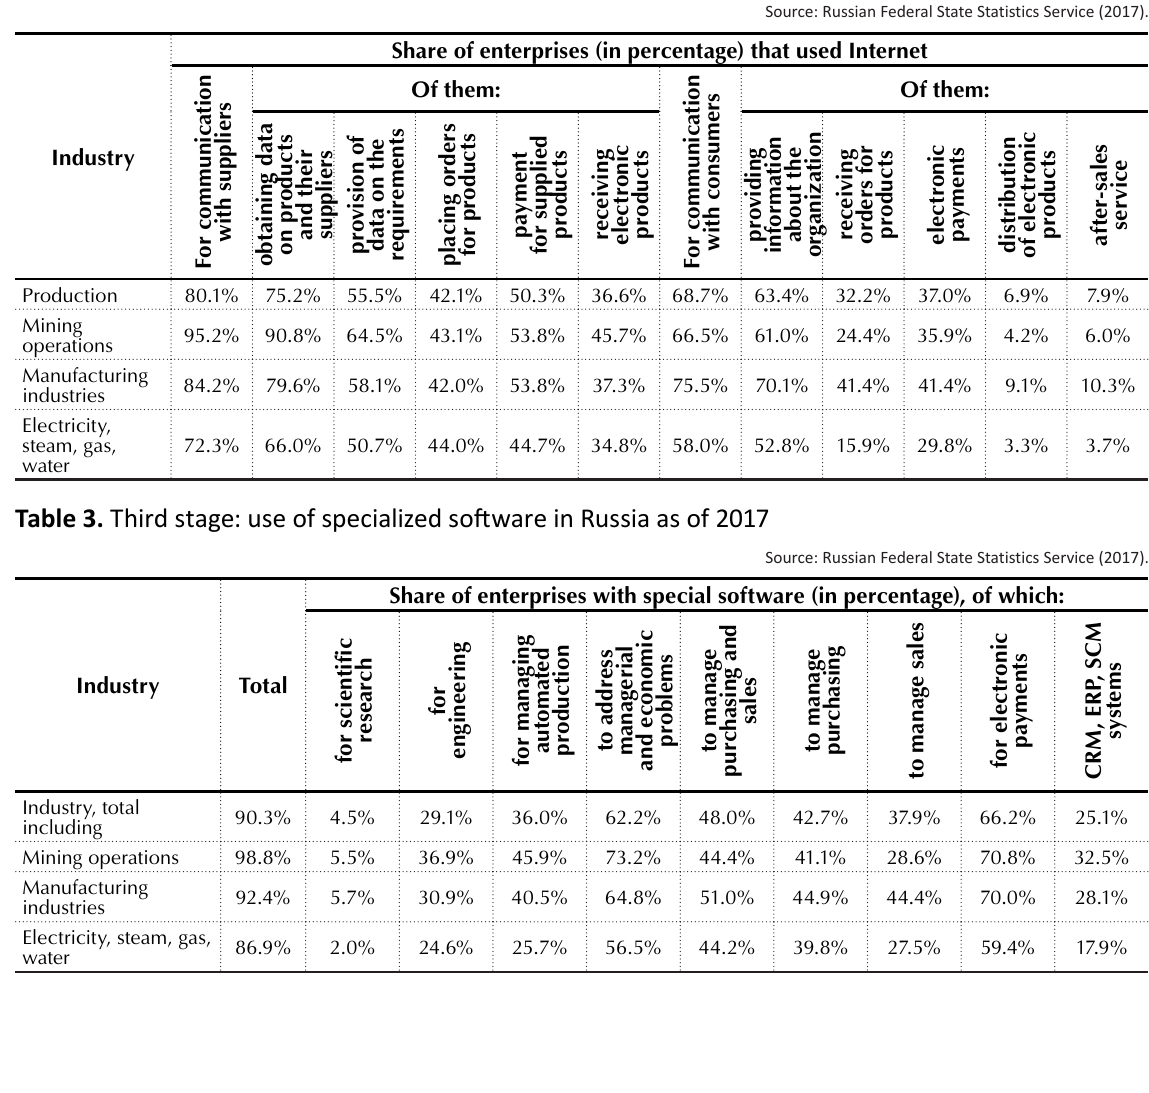
Table 2. Second stage: electronic data exchange in the chains of the final product creation and its sale to consumers in Russia as of 2017